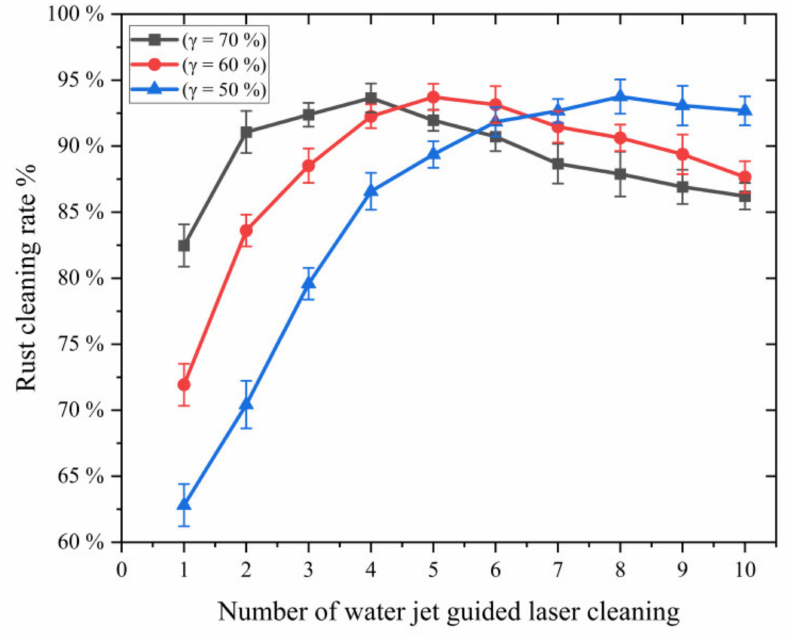
Figure 13. Effect of spot overlap rate of water jet-guided laser on cleaning